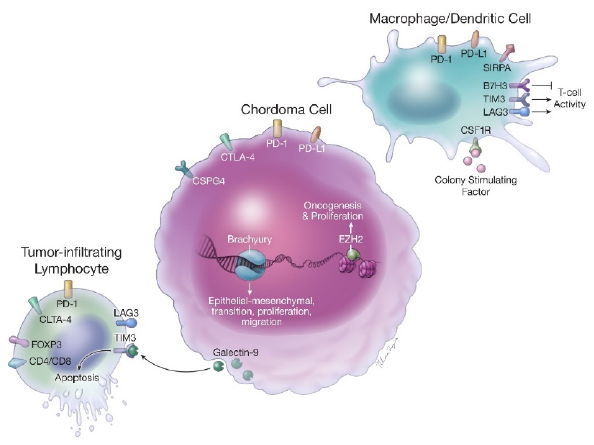
Figure 1. The chordoma immune microenvironment. In addition to the PD-1/PD-L1 pathway, other interactions between chordoma and the immune system have been elucidated. Chordomas positive for Galectin-9 (Gal9), a